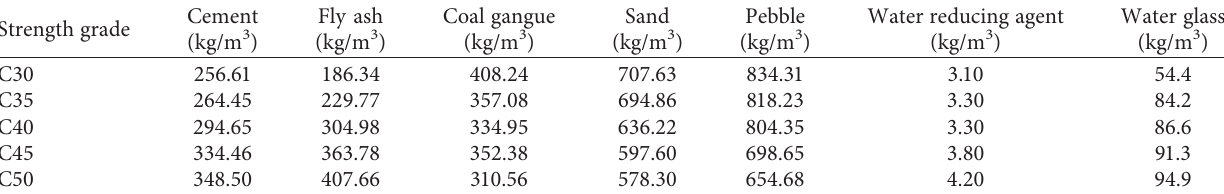
Table 10: Mix design optimization of different strength grades coal gangue-based geopolymer concrete based on Chebyshev mapping. Cement Strength grade